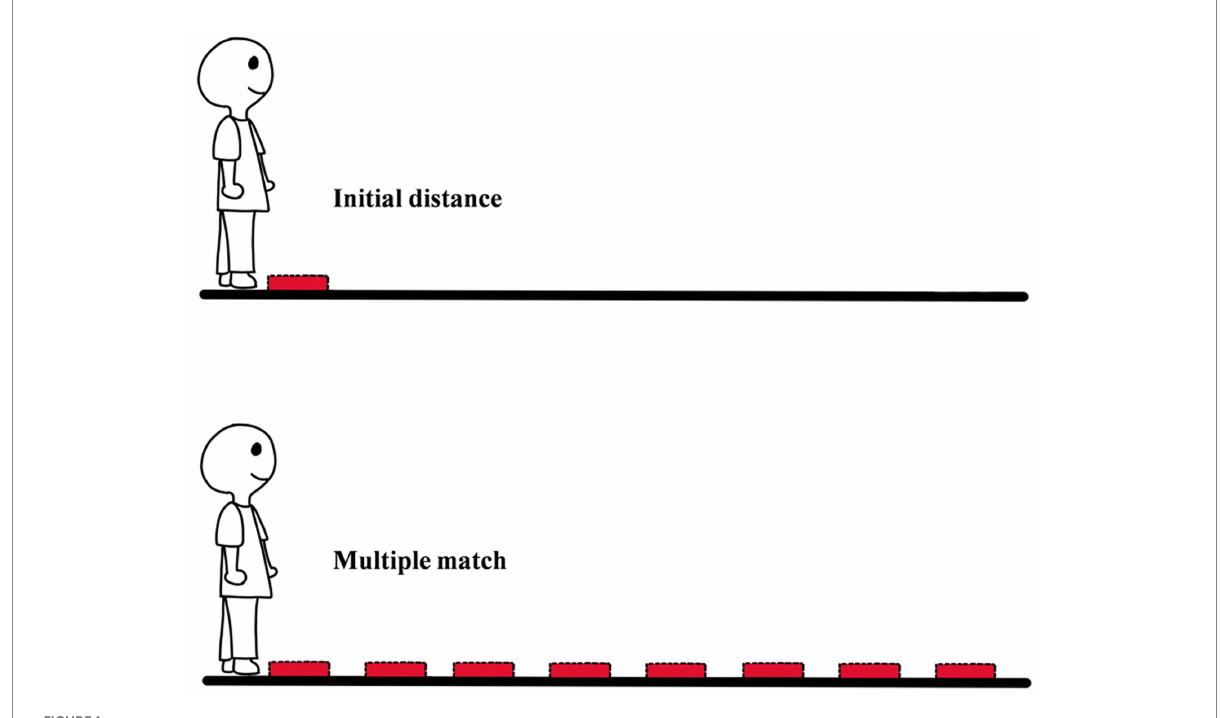
FIGURE 1 The diagram of successive equal-appearing intervals distance judgment